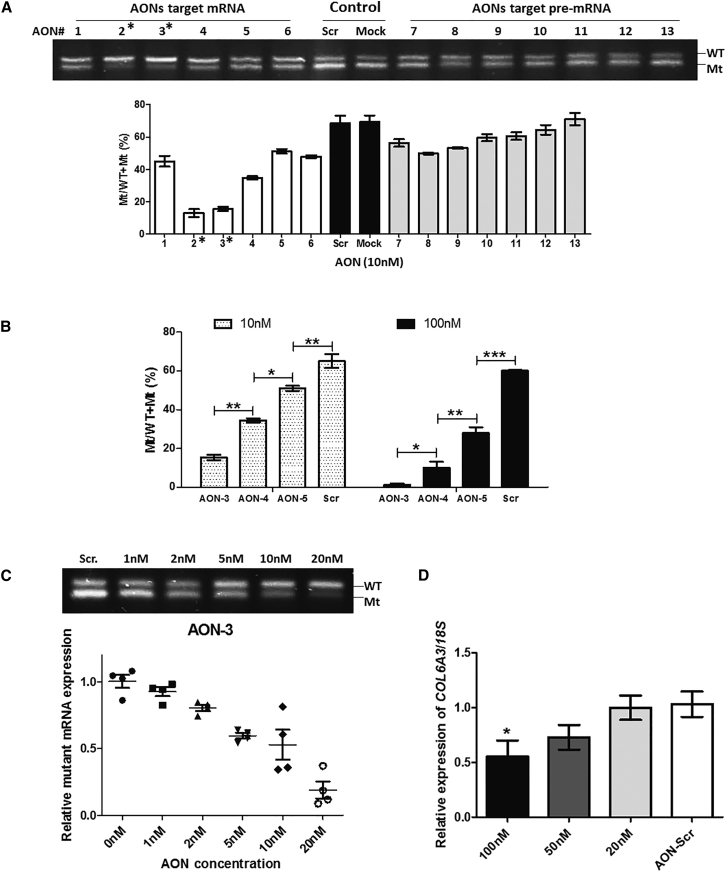
AON-3 Suppressed the Mutant Transcripts in a Dose-Dependent Manner(A) One-step reverse transcript PCR of mRNA isolated from patient fibroblasts treated with 13 AONs at 10 nM. Measurement was performed in three individual experiments (n = 3 per concentration). *AON-2 and AON-3 exhibited the most efficient suppression, over 80%, on the mutant transcripts. (B) Comparison of the efficiency of AON-3 (22-mer), AON-4 (18-mer), and AON-5 (16-mer), all with the same 8-nt DNA gap, in suppressing the mutant transcripts at concentrations of 10 nM and 100 nM, respectively. There was a significant difference between AONs with different lengths (*p < 0.05; **p < 0.01; ***p < 0.001; n = 3 per group). (C) Fibroblasts were treated with AON-3 at a range of concentrations of between 1 nM and 20 nM. The IC50 was identified at 5–10 nM. There was an approximately 90% reduction of the mutant transcripts in cells treated at 20 nM (n = 4 per concentration). (D) Effects of AON-3 on wild-type transcripts (n = 3 per concentration). At 100 nM, approximately 50% of wild-type COL6A3 transcripts were affected (*p < 0.05). No transcript reduction was detected at 20 nM. Data are presented as mean ± SEM.